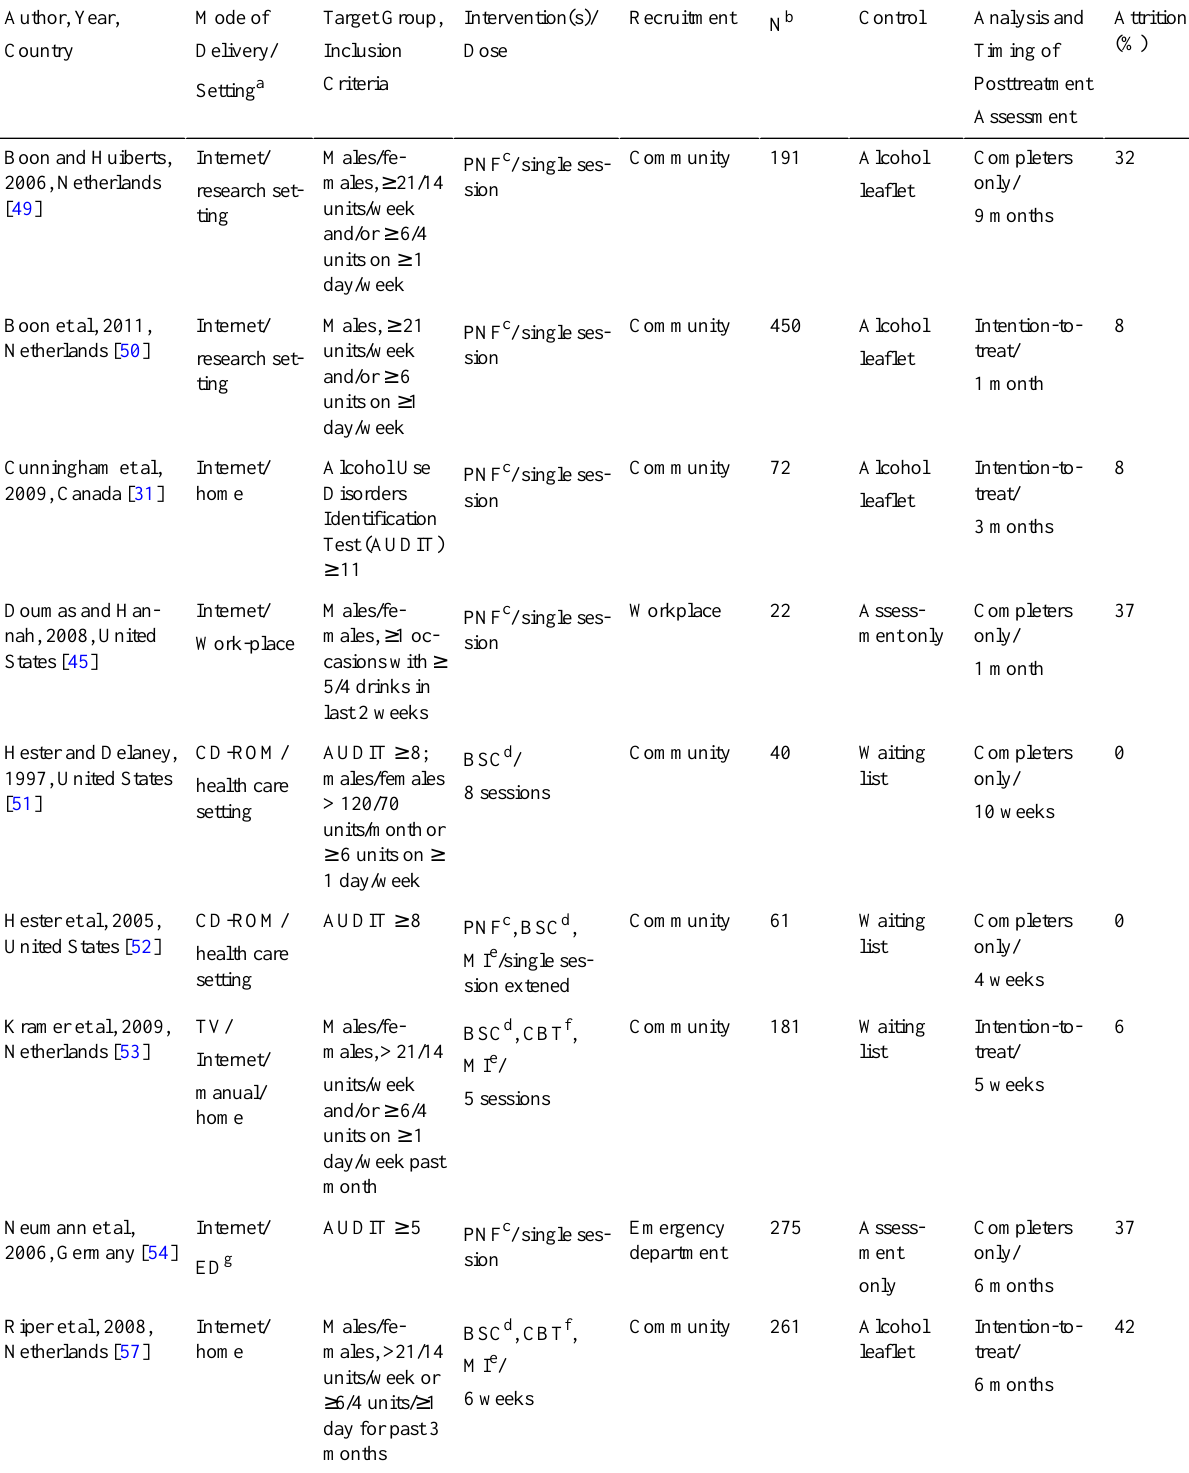
Table 1. Selected characteristics of studies (N = 9)